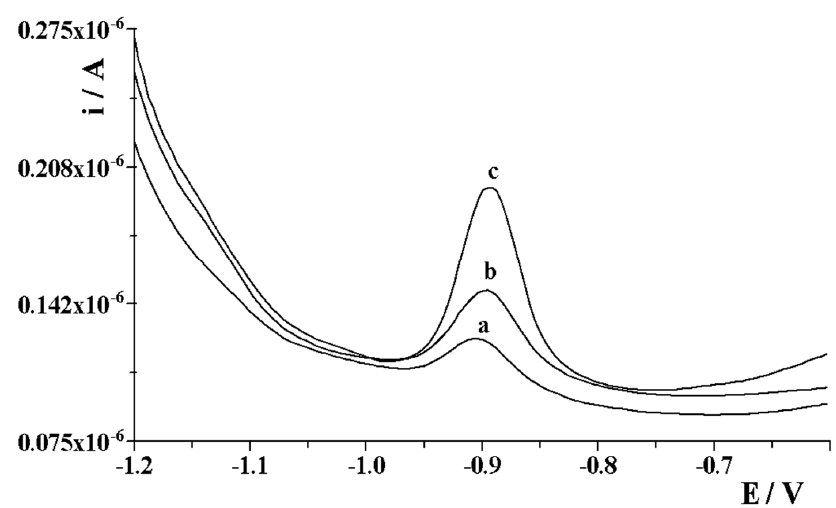
Figure 7. Voltammograms obtained in the course of gallium determination in Bystrzyca river water spiked with 2 × 10 − 7 mol L − 1 Ga(III) three hours before the measurement: (a) diluted four times; (b) as (a) + 5 × 10 − 8 mol L − 1 Ga(III); (c) as (a) + 1.5 × 10 − 7 mol L − 1 Ga(III).